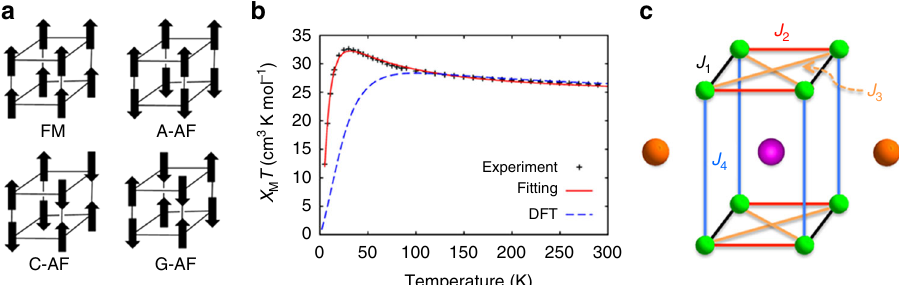
Fig. 2 Magnetic properties of Ce 3 Mn 8 and perovskites. a Four known spin-ordering con fi gurations in a perovskite unit cell. b Experimental χ M T vs T plot for Ce 3 Mn 8 in a 1 kG applied dc fi eld (+), with the small contributions from the two external Ce III ions subtracted. Solid and dashed lines are theoretical results from a multi-spin Heisenberg model using either exchange coupling J ’ s and anisotropy term D from fi ts to the experimental data ( solid line ) or calculated from fi rst-principles DFT ( dashed line ). c The multi-spin Heisenberg model showing the magnetic exchange coupling paths labeled as J 1 to J 4 ; colored lines indicate symmetry-equivalent sets. Other possible paths (unlabeled) correspond to exchange coupling strengths at least an order of magnitude smaller than the ones labeled in the